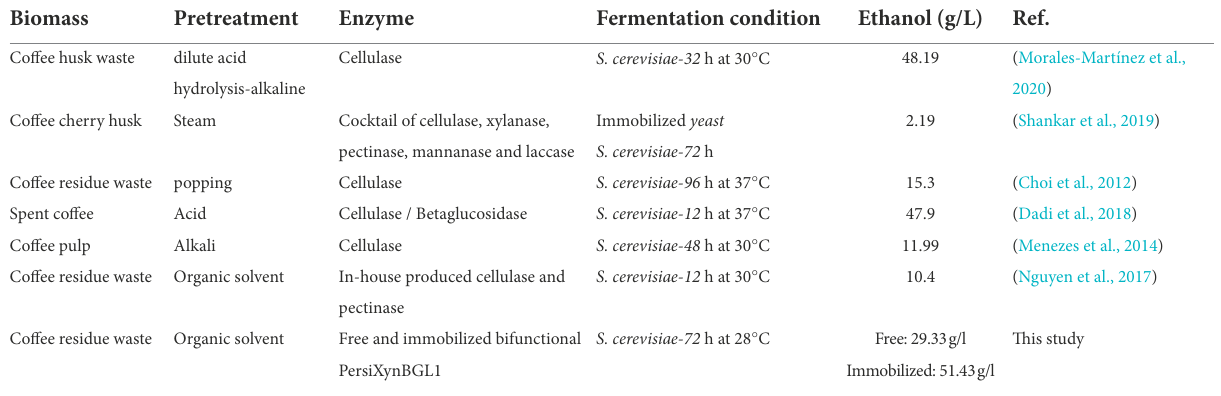
TABLE 3 Comparison of ethanol yields obtained after enzymatic hydrolysis and fermentation by different cellulase and hemicellulose enzymes with the free and immobilized PersiXynBGL1.